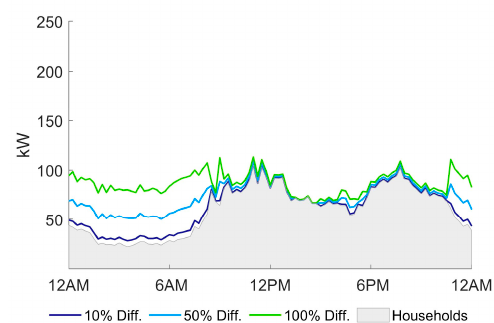
Figure 9. Household load and charging profile applying the time-of-use (ToU) approach.